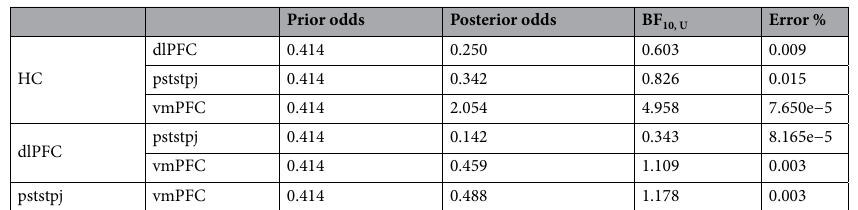
Table 4. Post Hoc comparisons for god image score. The posterior odds have been corrected for multiple comparisons by fixing to 0.5 the prior probability that the null hypothesis holds across all comparisons 43 . Individual comparisons are based on the default t-test with a Cauchy (0, r = 1/sqrt(2)) prior. The "U" in the Bayes factor denotes that it is